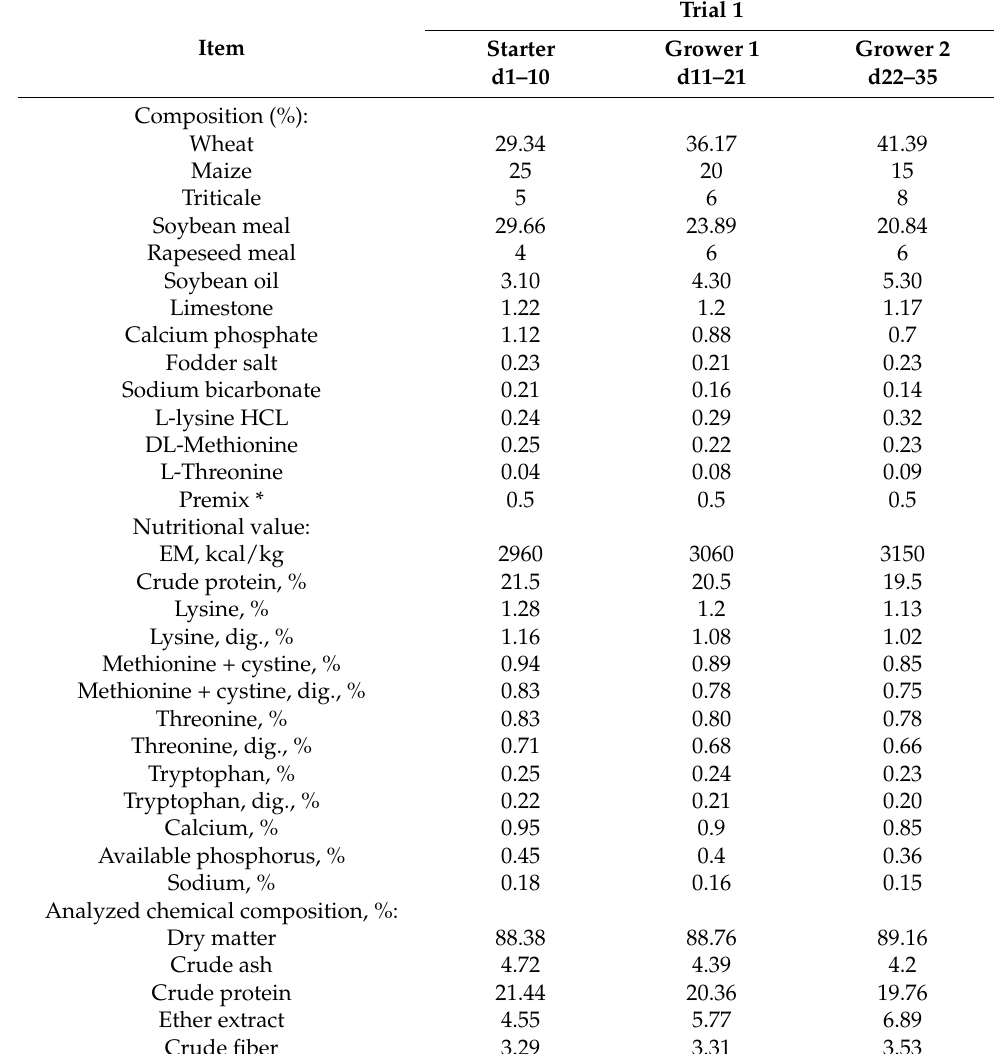
Table 1. Composition and nutritional value of basal diets for trial